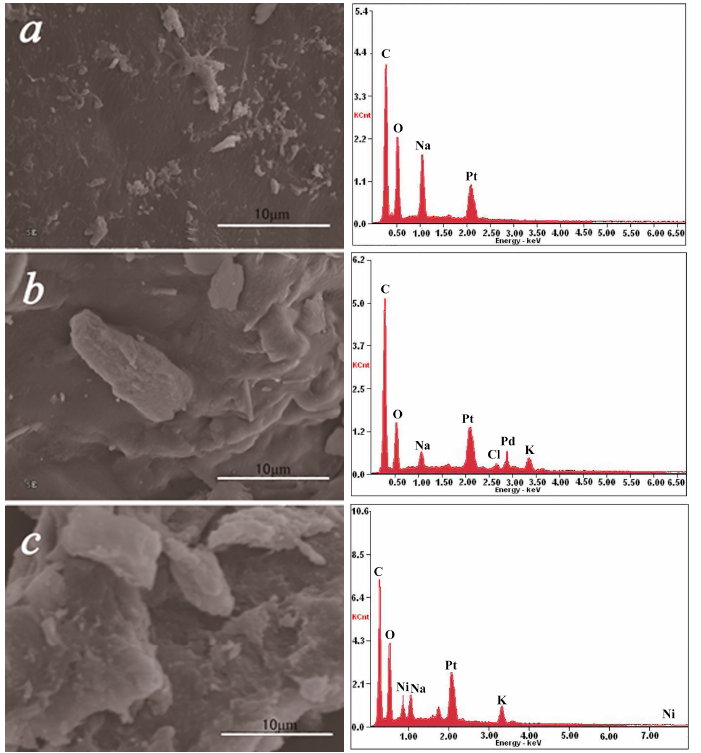
Figure 4. Scanning electron microscopy pictures and SEM/EDS spectra of ( a ) OCMCS; ( b ) OCMCS-Pd; ( c ) OCMCS-Ni.